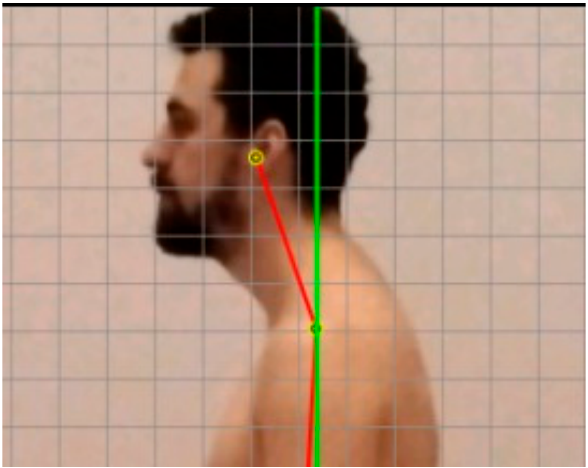
Figure 1. Forward head posture measurement.